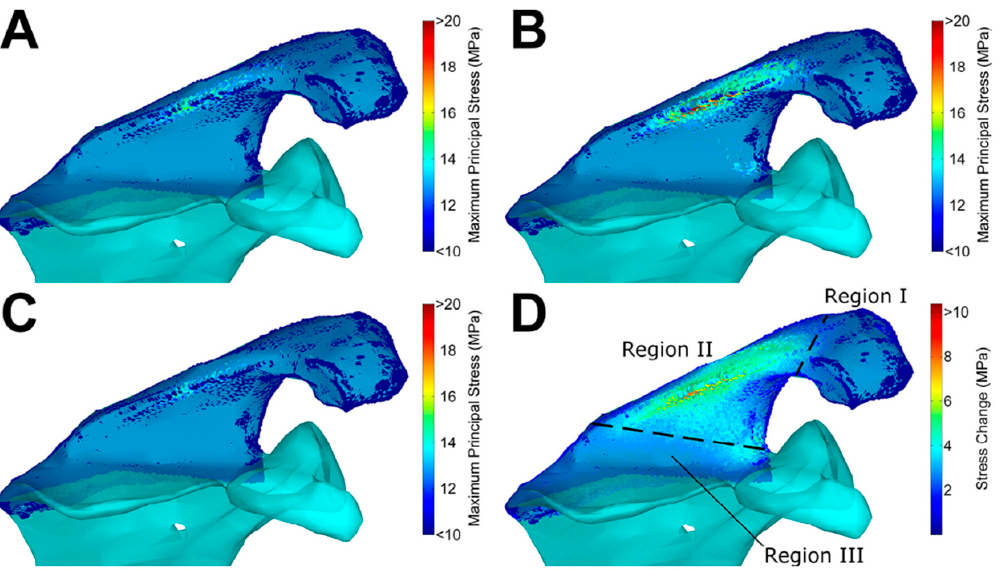
Figure 3. Finite element analysis on the influence of implant positioning in reverse total shoulder arthroplasty on acromial and scapular spine stresses by Wong et al. [47]. Reprinted with permission from ref. [47]. Copyright 2016 Elsevier. ( A ) Baseline implant configuration, ( B ) maximum stress configuration, ( C ) minimum stress configuration, and ( D ) stress increase from minimum to maximum stress configuration. Regions are as defined by Levy et al. [20].